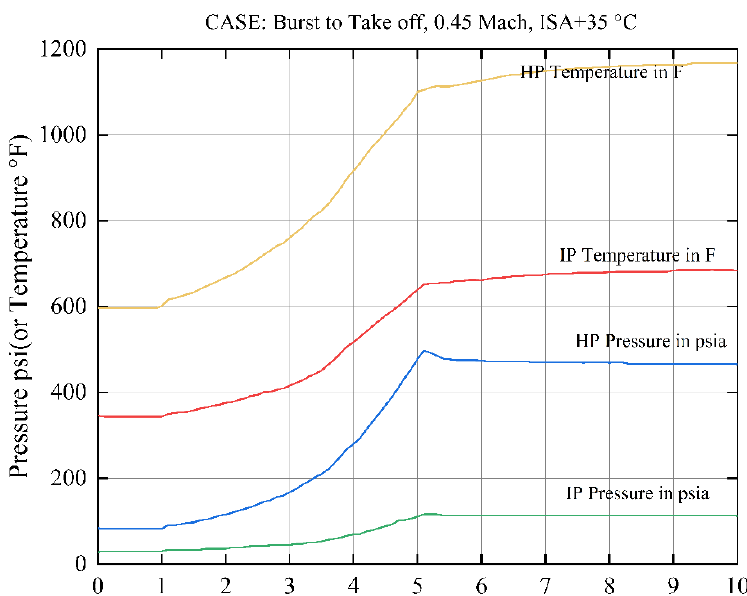
Figure 1. Schematic diagram of engine bleed air.